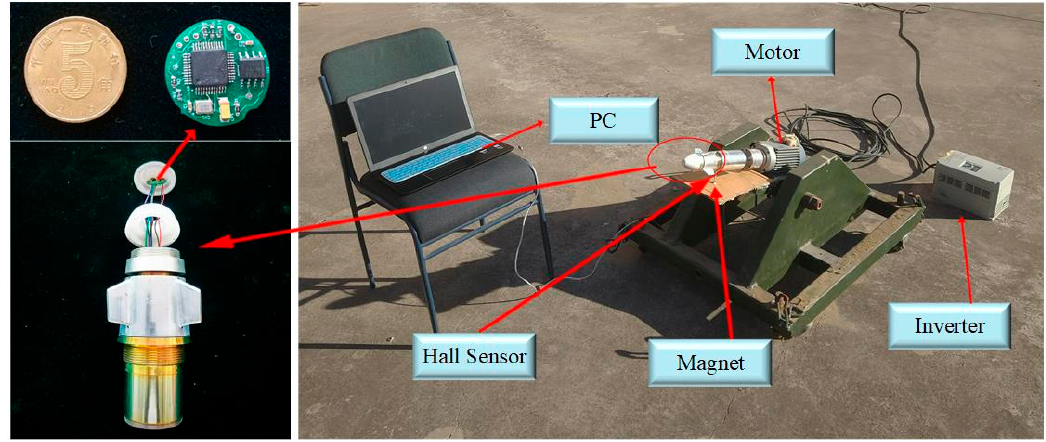
Figure 19. Experiments on rotary table .